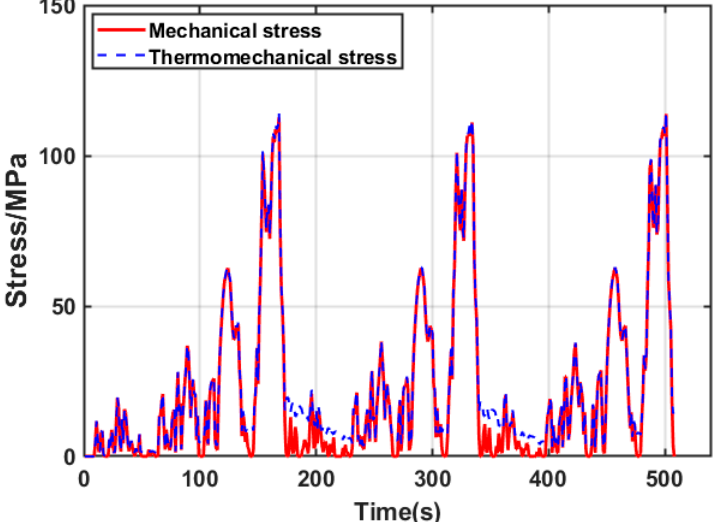
Figure 17. Stress comparison curve at the magnetic bridge.